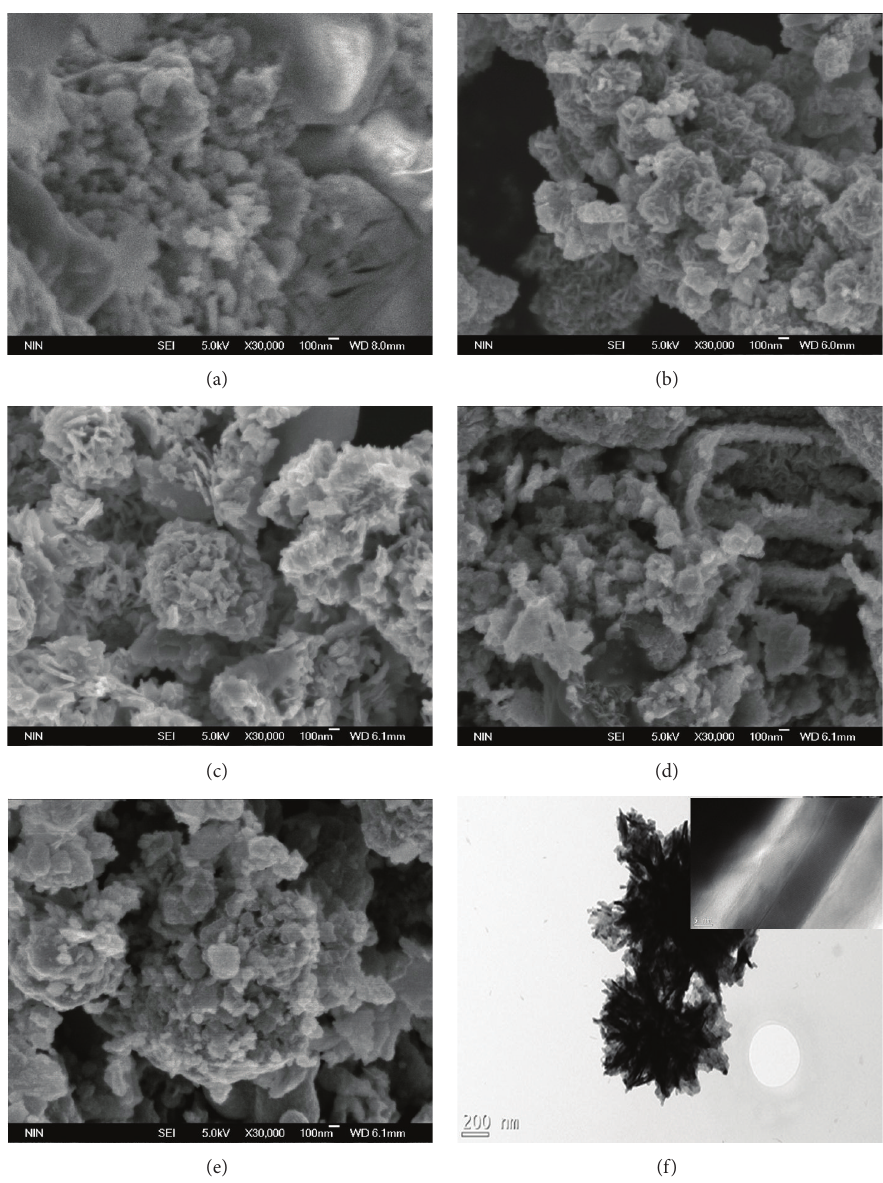
Figure 1: SEM images of the obtained samples at 200 ∘ C for 7.5h as the function of different ethanol contents: (a) 100% H 2 O, (b) 25% CH 3 CH 2 OH, (c) 50% CH 3 CH 2 OH, (d) 75% CH 3 CH 2 OH, and (e) 100% CH 3 CH 2 OH; (f) TEM image of sample from 50% CH 3 CH 2 OH (inset is TEM image of